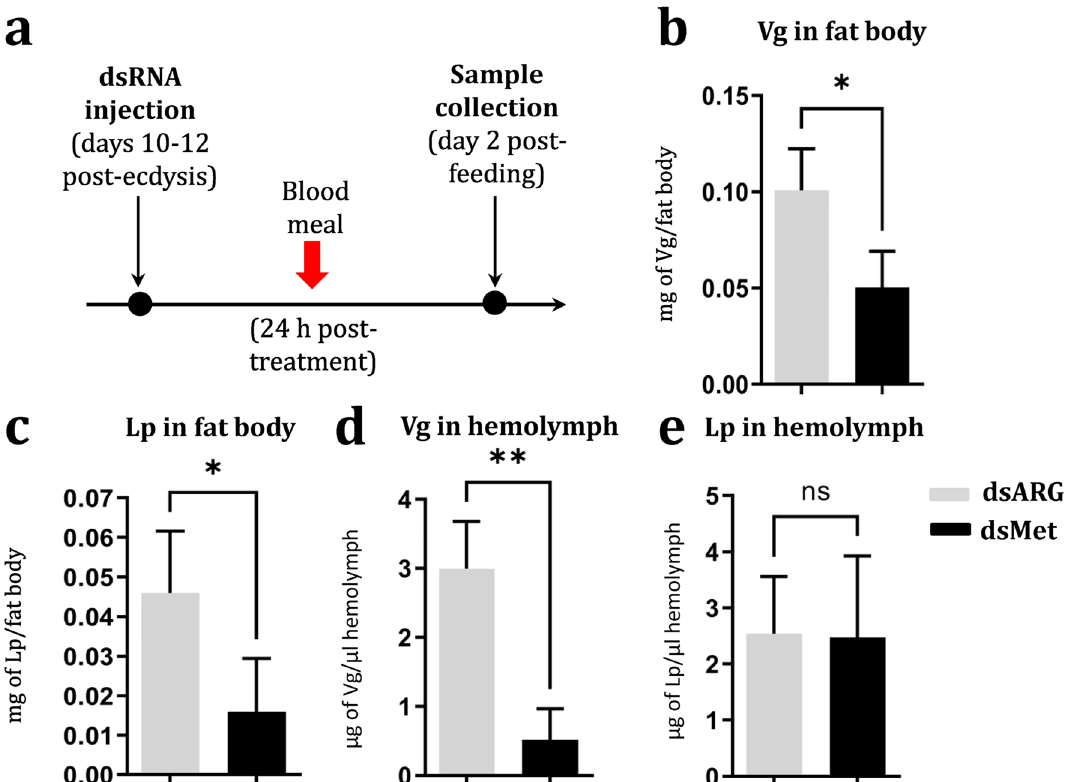
Figure 4. Effect of DmaxMet gene silencing on vitellogenin and lipophorin protein levels. ( a ) Experimental scheme. Effect of dsMet and dsARG (control) treatment on Vg ( b ) and Lp ( c ) in the fat body. Effect of dsMet and dsARG treatment on Vg ( d ) and Lp ( e ) levels in hemolymph. The results are shown as mean ± SD of three independent experiments and included samples from insects processed individually ( n = 3). * P < 0.05; ** P <